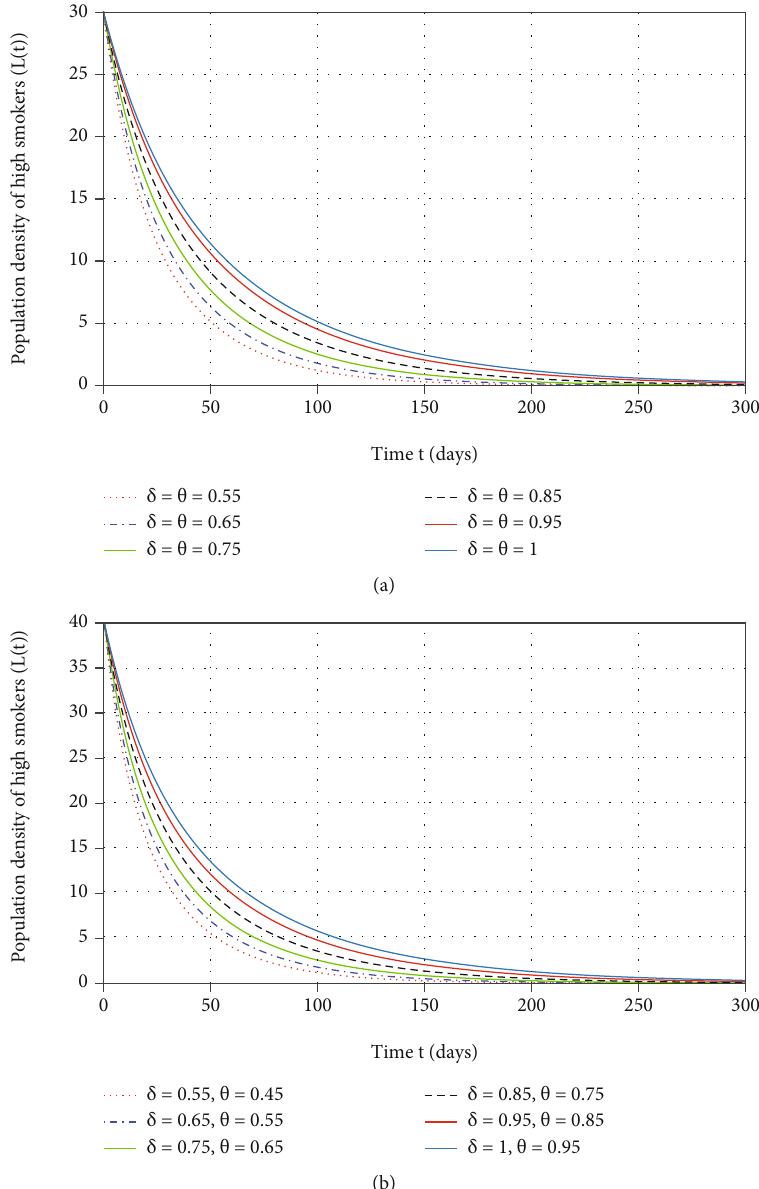
= 30 , 40 in the model under investigation 0